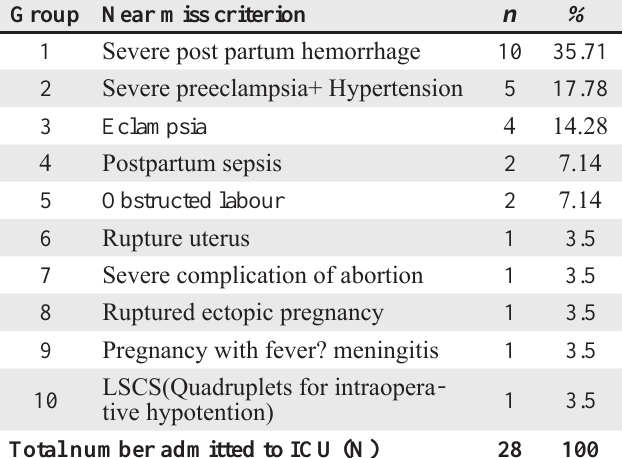
Table 2 : Study group according to WHO near miss criteria.